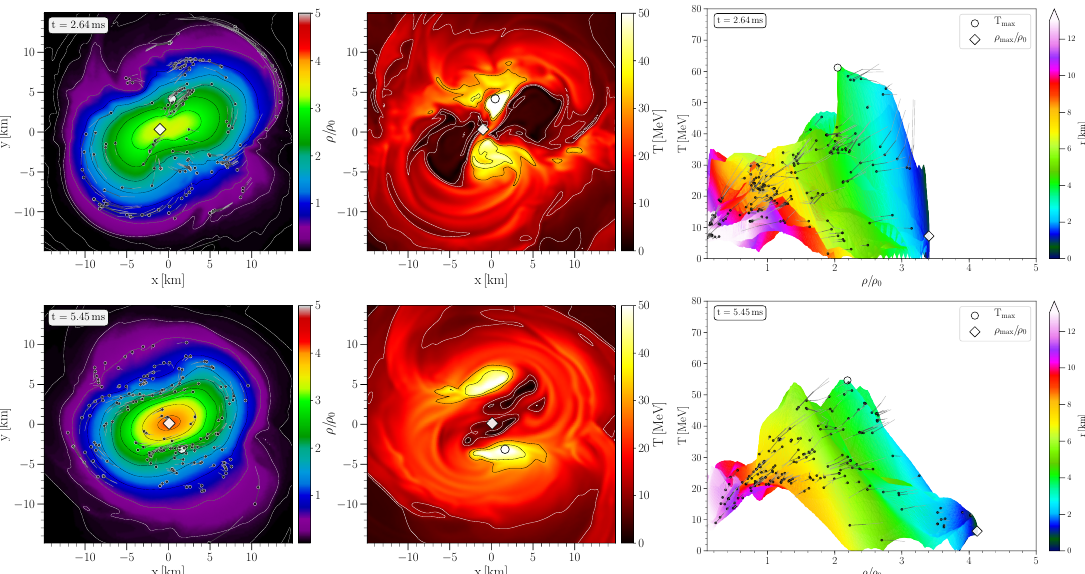
Figure 3. Same as Figure 2 but for later time snapshots within the transition segment from the early to the middle part of the post-merger phase.